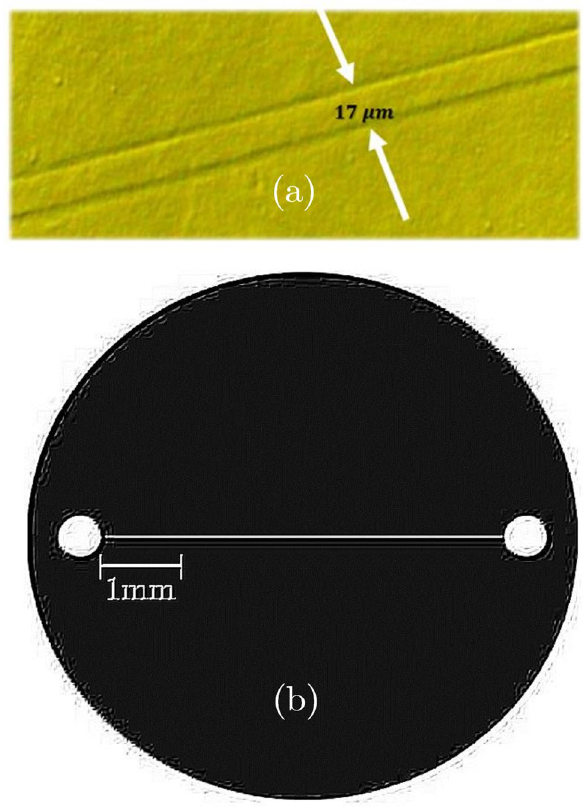
Figure 4. ( a ) Shear stress channel embedded in the polydimethylsiloxane, PDMS, ( b ) embedded 17-micron channel to create shear